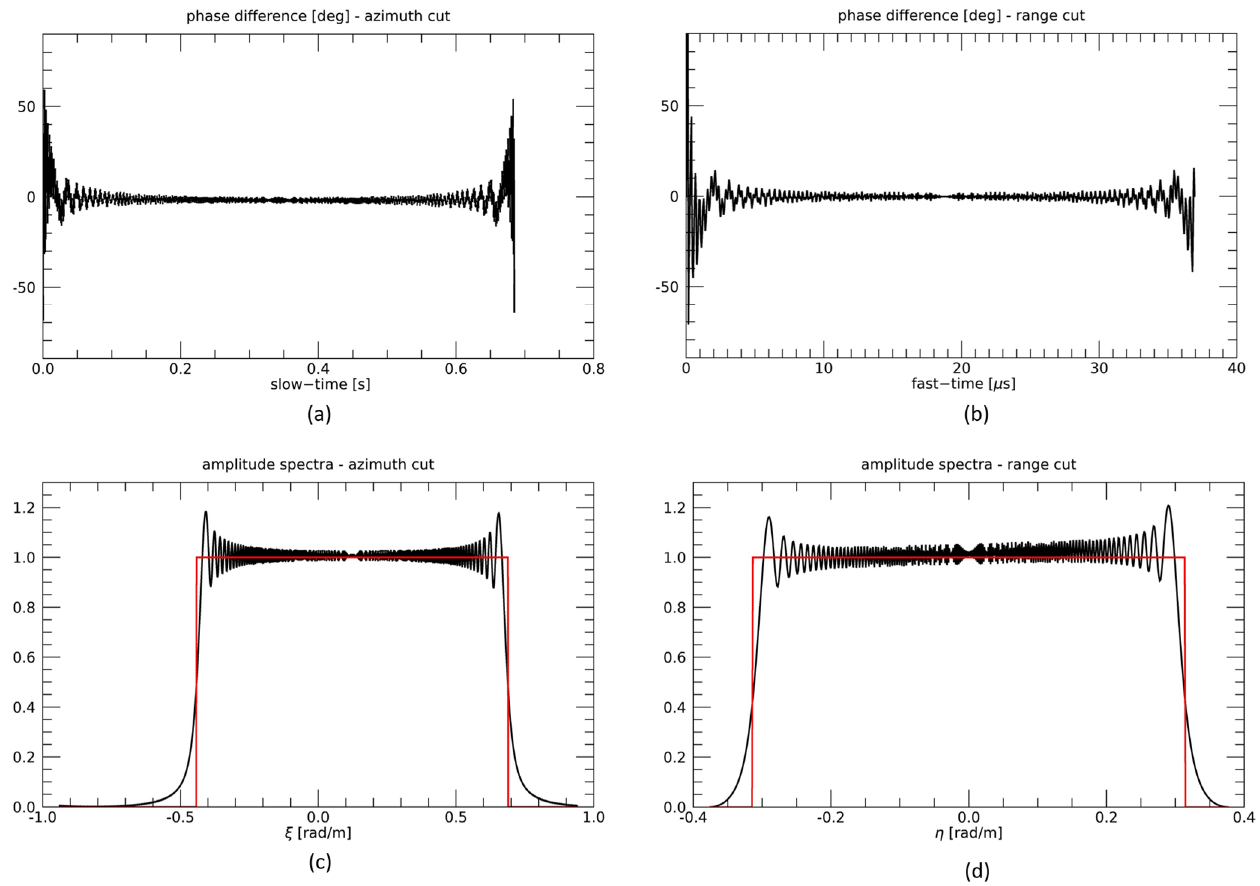
Figure 7. TI configuration, third example. Slow-time ( a ) and fast-time ( b ) cuts of the difference between the phases of the raw signals simulated in time and frequency domains. Slow-time ( c ) and fast-time ( d ) cuts of spectra of raw signals generated via the time (black line) and frequency (red line) domain simulators. Table 2. Systemparameters ofthe one-stationarybistatic SARconfiguration considered inthe